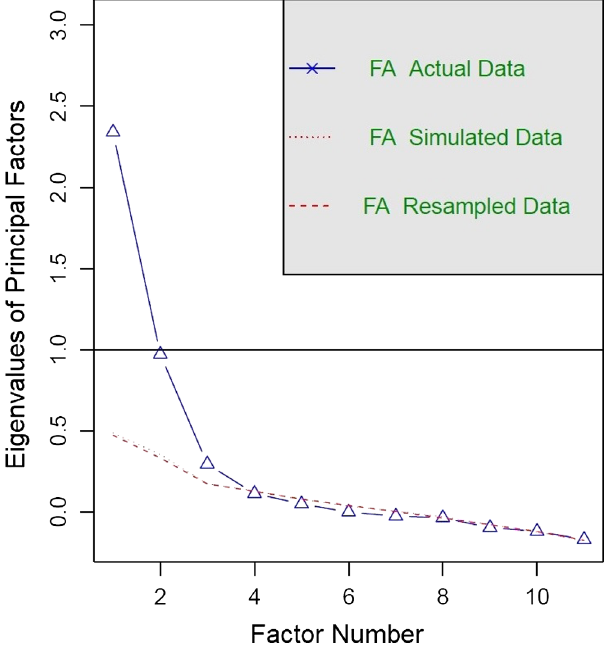
FIG. 1. Parallel analysis scree plot of 21-item survey, with overlaid Kaiser criterion cutoff; factor analysis